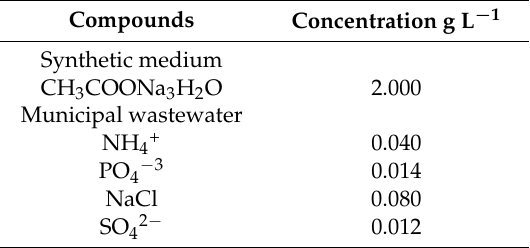
Table 4. Municipal wastewater composition and synthetic